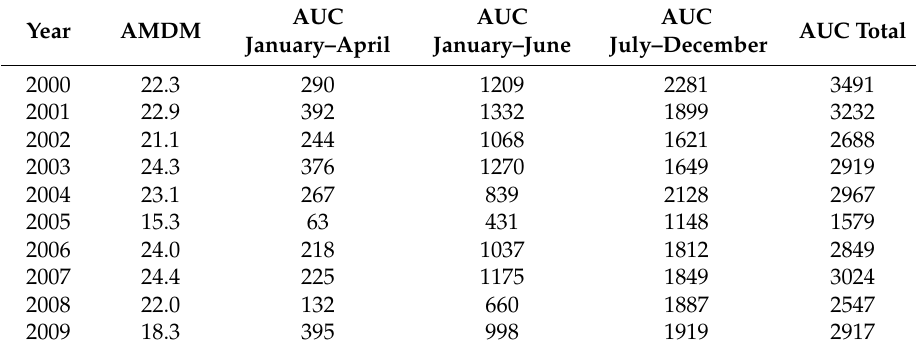
Table 4. Annual summary metrics for a site located in the North Fork John Day above the confluence with Camas Creek. Annual maximum daily mean (AMDM), total Area Under the Curve (AUC) in °C,